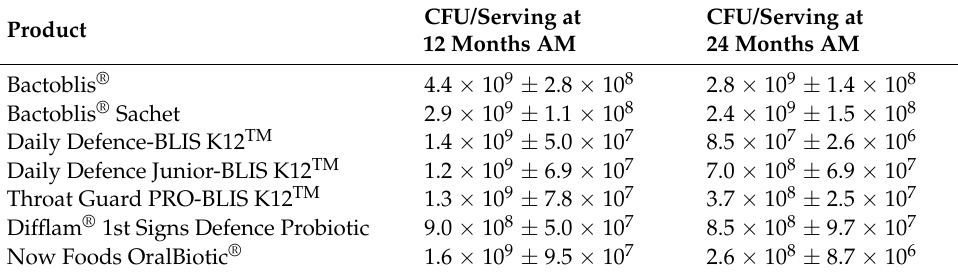
Table 3. Probiotic viability in the examined commercial products at 12 and 24 months AM.